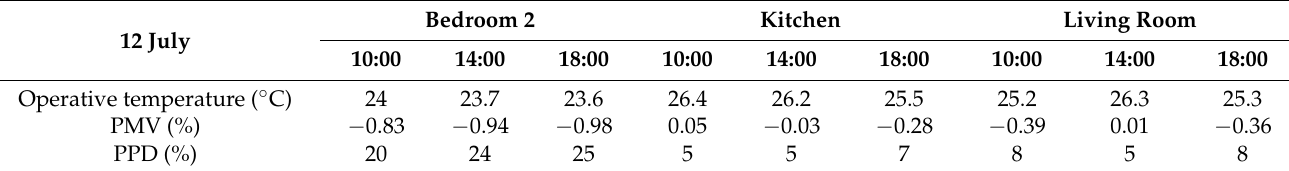
Table 7. PMV and PPD values calculated on 12